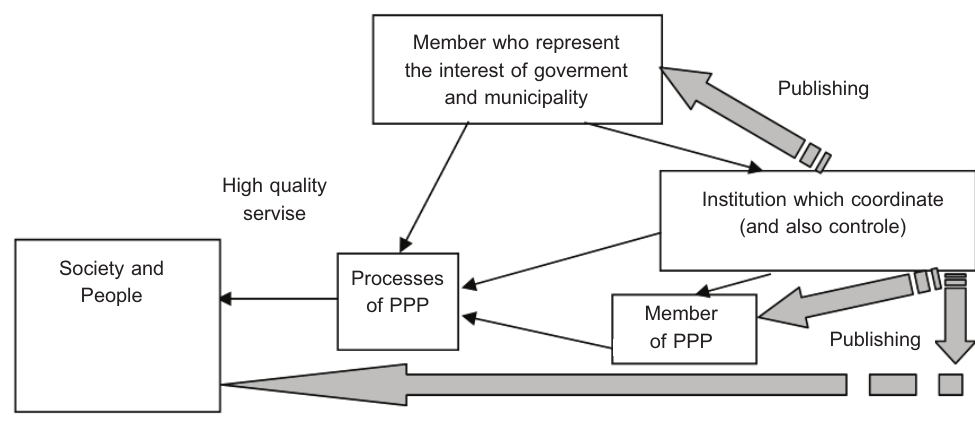
figure. 2. Public- private partnership